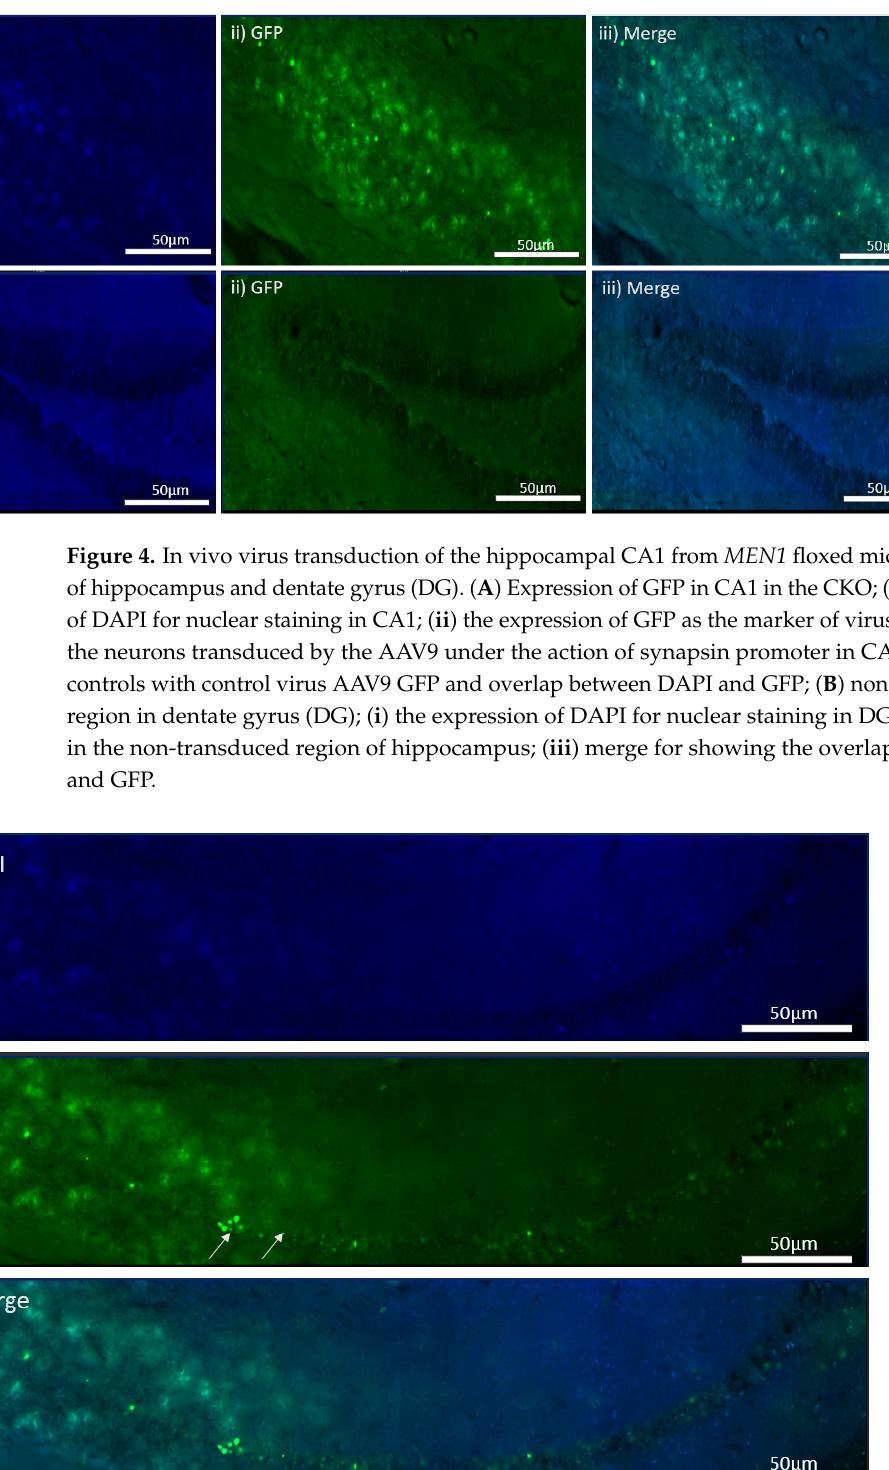
Figure 6. Ectopic expression in the hippocampus of the mice injected with AAV9 under the function of synapsin promoter and GFP as the marker for the virus transduction. ( i ) The expression of DAPI